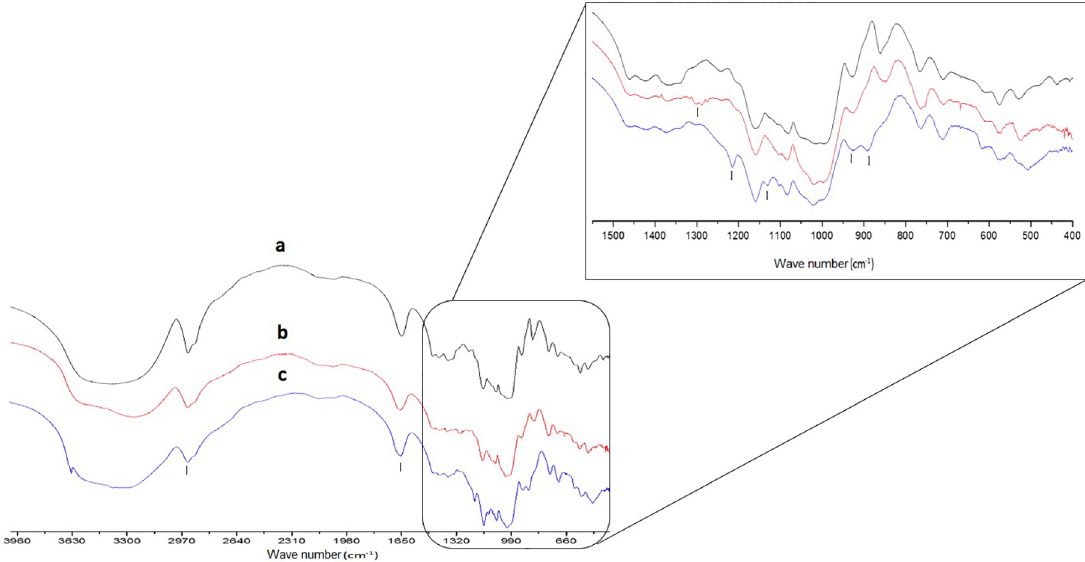
Figura 2. FTIR absorption spectra of samples (a) ST (b) ST-TM and (c)